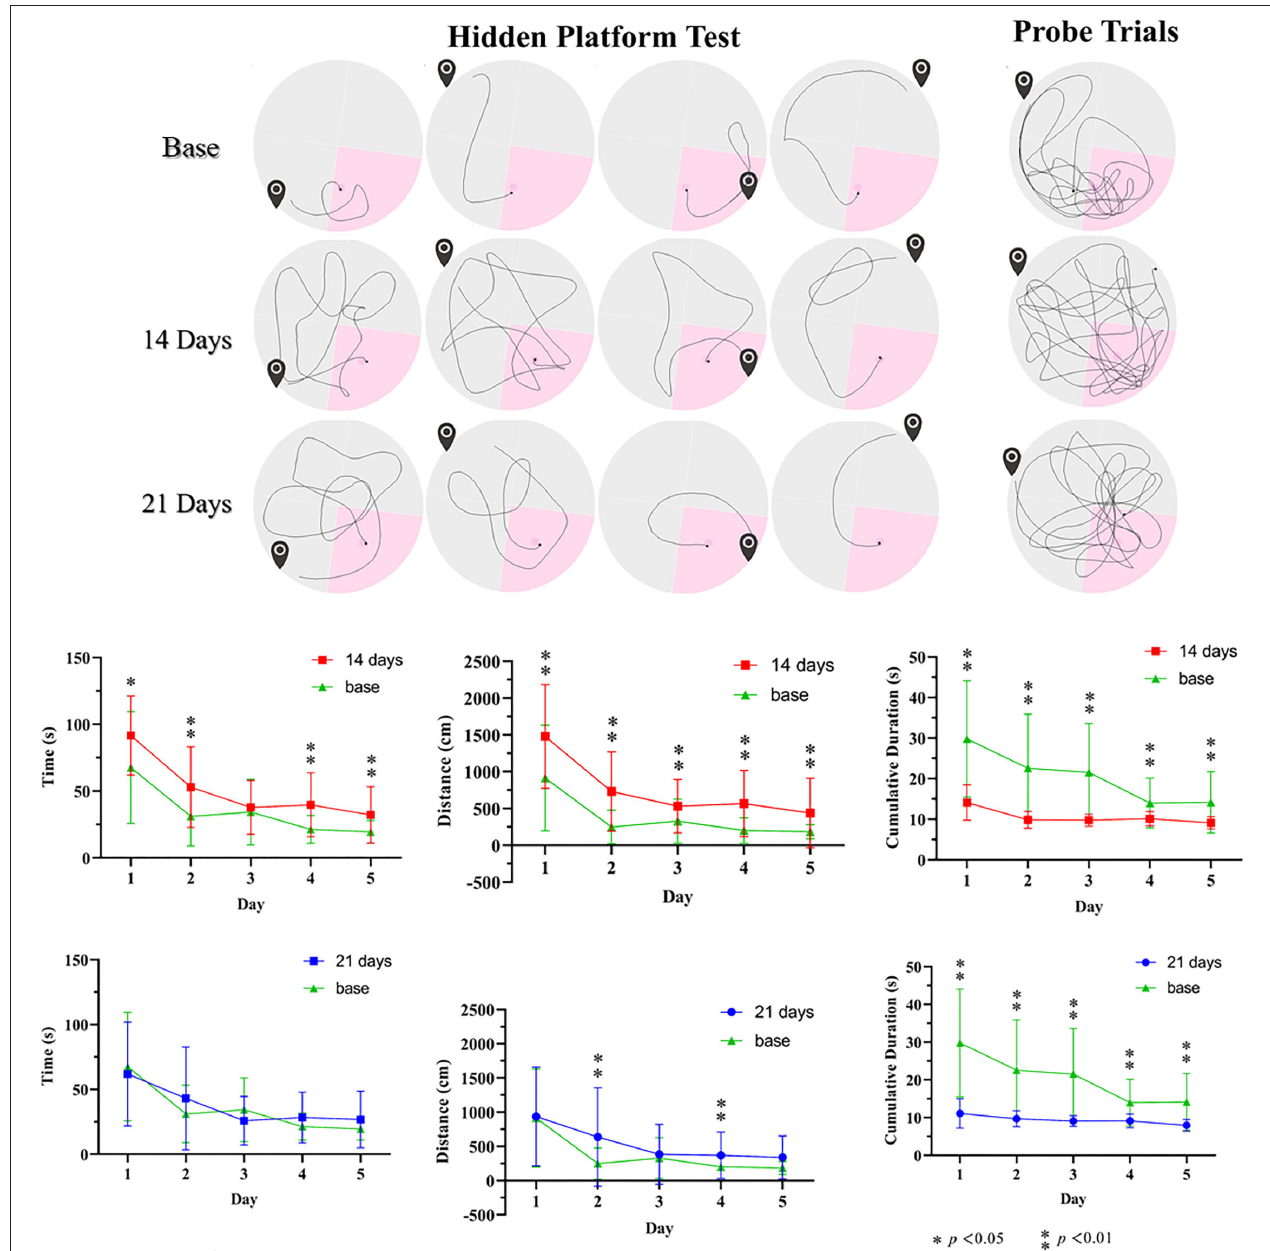
FIGURE 6 | Illustration of pathways before and after CO poison in the Morris water maze and related data. * p < 0.05, ** p < 0.01.